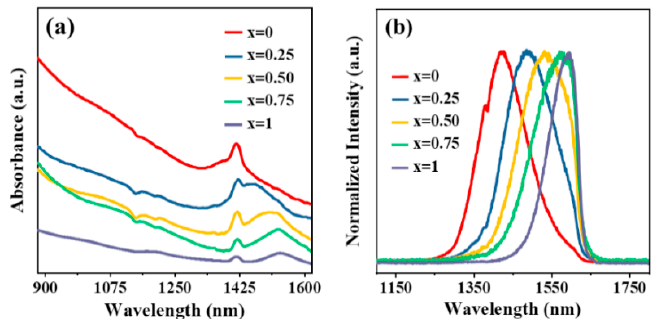
Figure 2. ( a ) Absorption spectra (offset for clarity) and ( b ) PL spectra of PbS 1 − x Se x QDs.